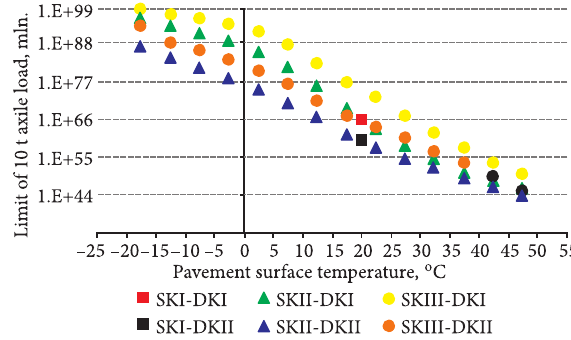
Fig. 4. The horizontal strain change in pavement structure depending on distance for load centre